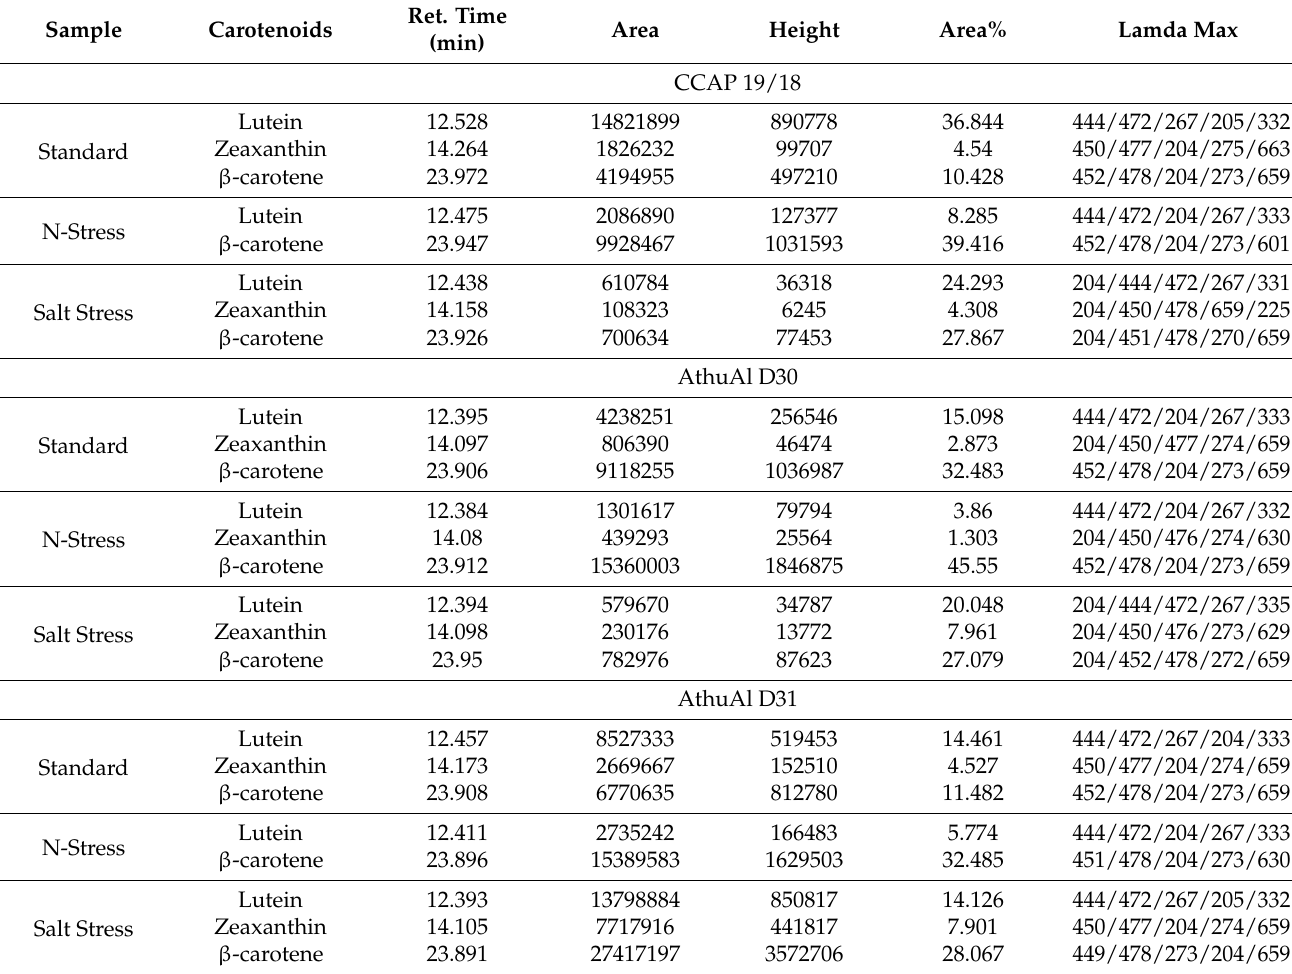
Table 2. Chromatographic features of the studied strains, regarding lutein, zeaxanthin and β -carotene content, in different culture